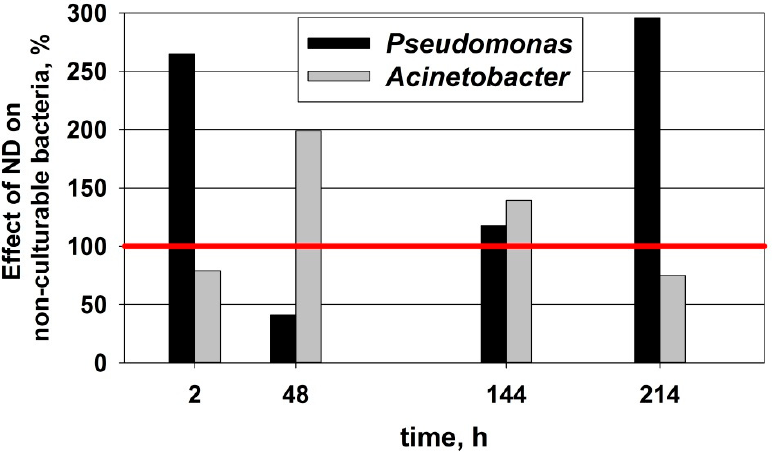
Figure 8. Effect of ND on non ‐ culturable bacteria of the genus Pseudomonas and the genus Acineto ‐ bacter